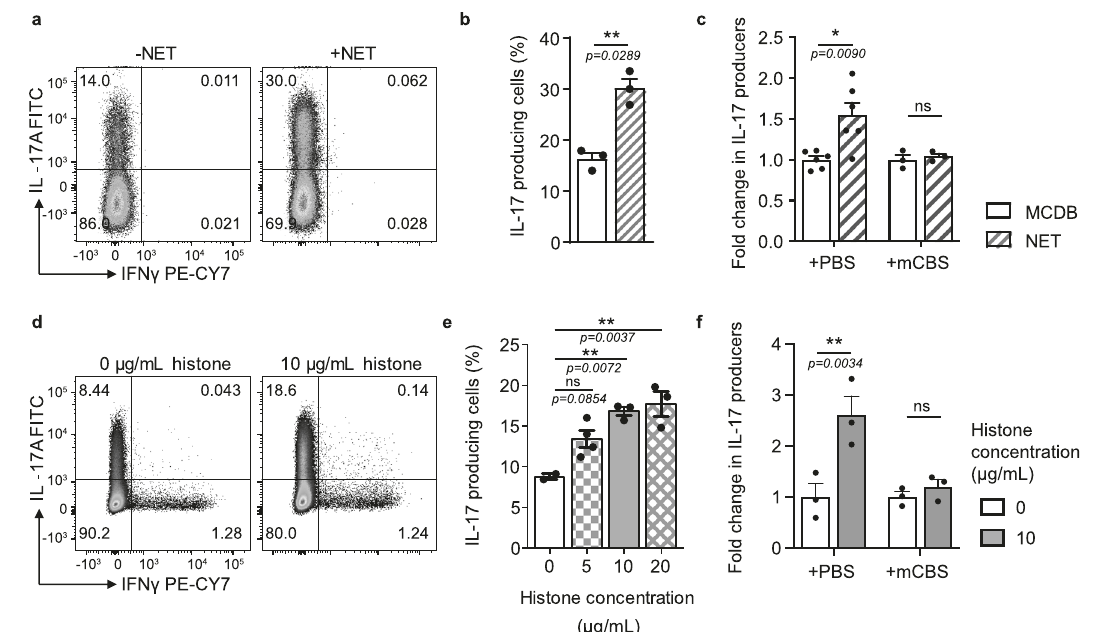
Fig. 1 Neutrophil extracellular traps (NETs) promote Th17 cell differentiation through histones. a , b IL-17 and IFN γ expression by in vitro differentiated Th17 cells measured by fl ow cytometry after culture in the presence or absence of in vitro generated NETs n = 3. c Normalized IL-17 production by Th17 cells differentiated in the presence of NETs in MCDB media or MCDB media alone with the addition of histone inhibitor mCBS. d , e IL-17 and IFN γ expression by in vitro differentiated Th17 cells cultured with a low concentration of histones (0 – 20 µ g/mL) n = 3. f Normalized IL-17 production of Th17 cells differentiated with histones with the addition of histone inhibitor mCBS n = 3. Data bars show mean ± SEM. “ ns ” (not signi fi cant), p > 0.05; “ * ” p < 0.05; “ ** ” p < 0.01. b Paired two-tailed t -test, c , f two-way ANOVA with Sidak ’ s multiple comparisons test, e one-way ANOVA with Tukey ’ s multiple comparisons test. Data points represent individual mice. All data are representative of a minimum of two independent experiments. Source data are provided as a Source Data fi